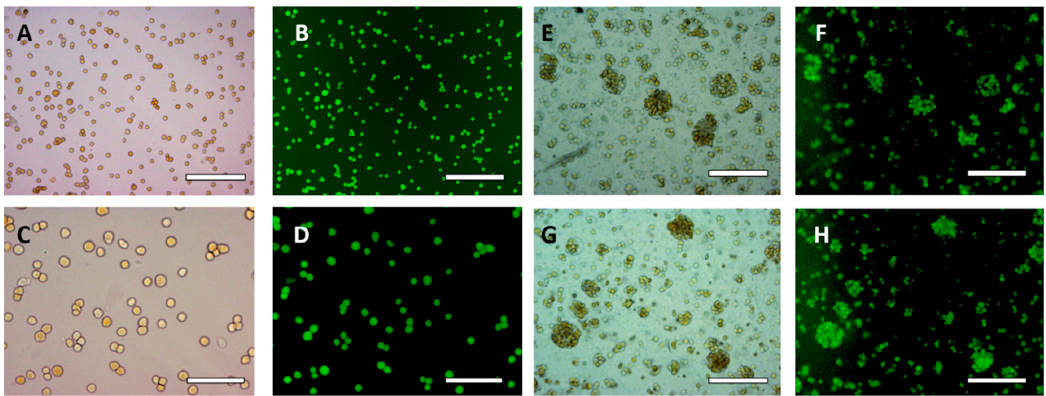
Figure 4. ( A , C ) Optical bright field images and ( B , D ) fluorescence microscope images of single HaCaT cells after being treated with FDA live/dead assay. ( E , G ) Optical bright field images and ( F , H ) fluorescence microscope images ( F , H ) of HaCaT cell clusteroids treated with FDA. FDA treatment was done on after the cell clusteroids fabrication. The fluorescence indicates that both the HaCaT cells preserve their viability during the clusteroids fabrication process, as described in Figure 1. Scale bars are ( A , B , E , F , G , H ) 200 µ m and ( C , D ) 100 µ